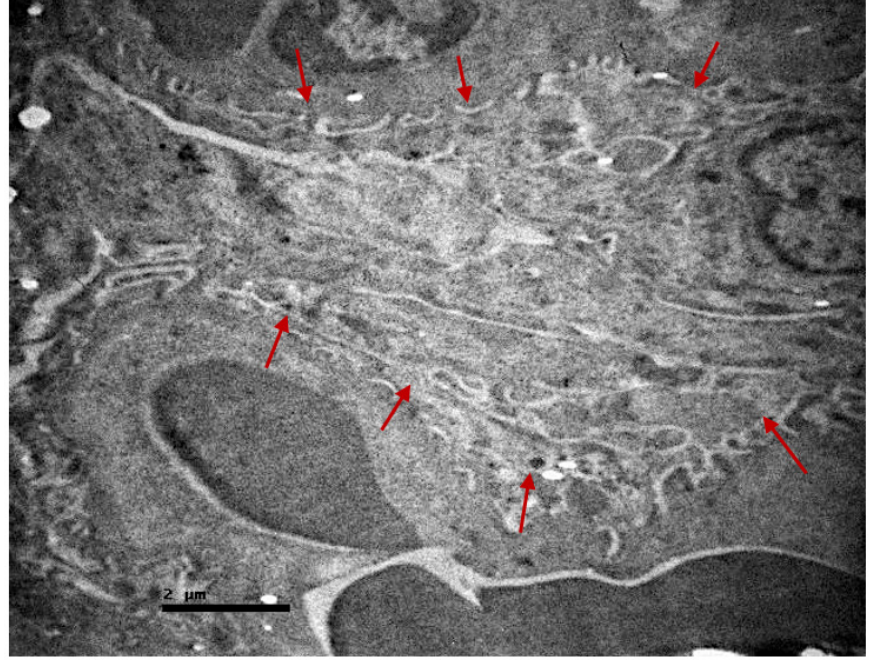
Figure 11. Renal corpuscle of non-resuscitated swine sample shows fusion of the podocytes (site among red arrows).